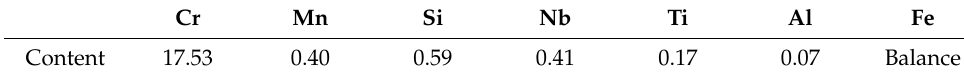
Table 1. Composition of the AISI 441 stainless steel (wt.%).